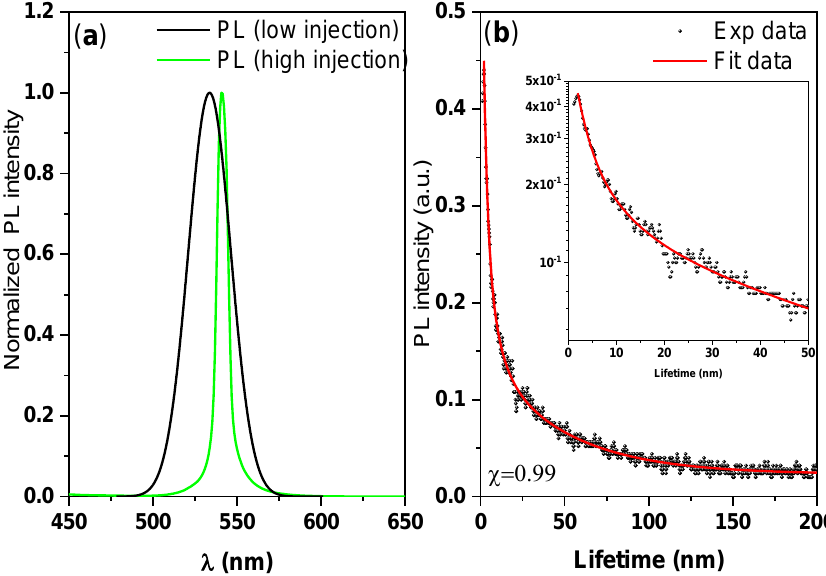
Figure 4. PL measurements: ( a ) Steady-state PL spectra and ( b ) time-resolved PL of the CsPbBr 3 / PMMA thin disk.